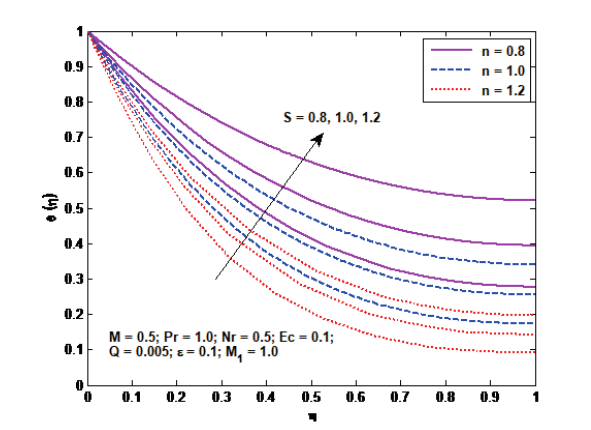
Fig. 6: Temperature profiles for different values of M